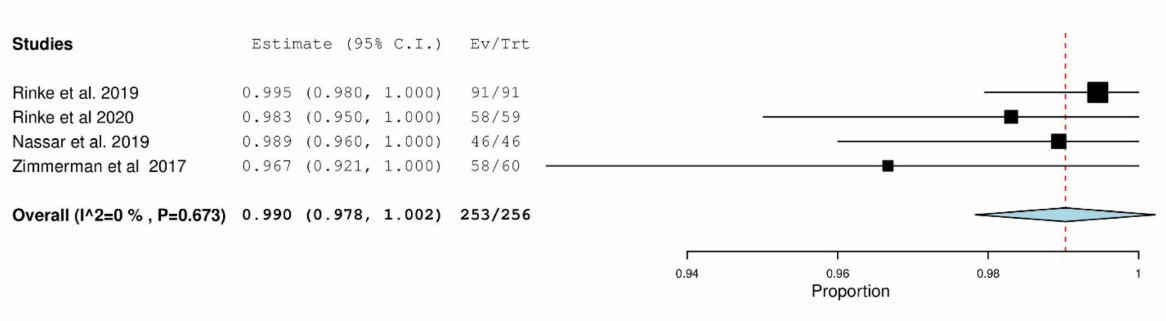
Figure 4. One-year survival forest plot for